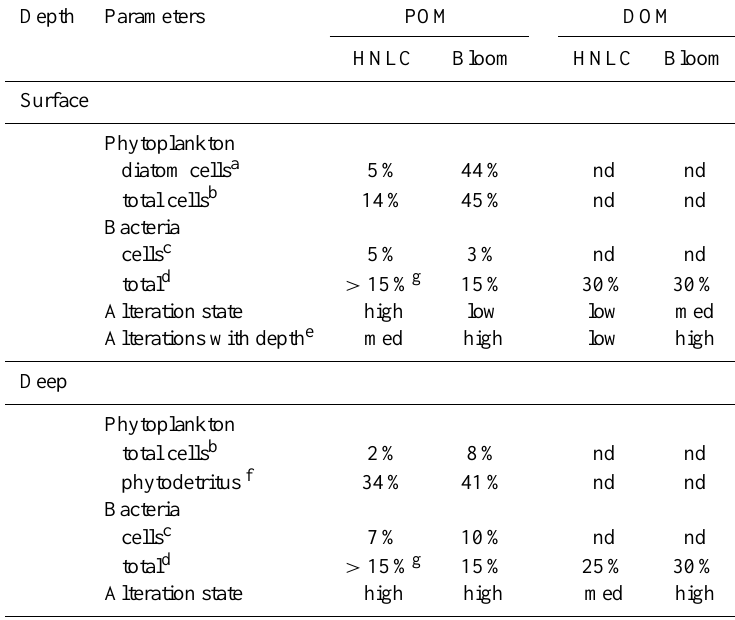
Table 3. Summary of the characteristics of POM and DOM in HNLC waters (station R-2) and at the bloom site above the Kerguelen Plateau (station A3-2). Surface refers to 10–90m depth layer and deep refers to 210–300m depth. Contributions to POM and DOM are average values given as percent of bulk organic